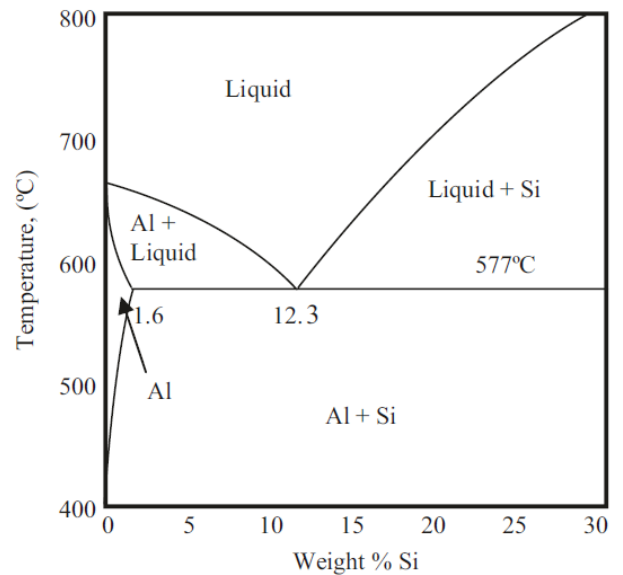
Figure 1. Section of binary Al–Si phase diagram [2].